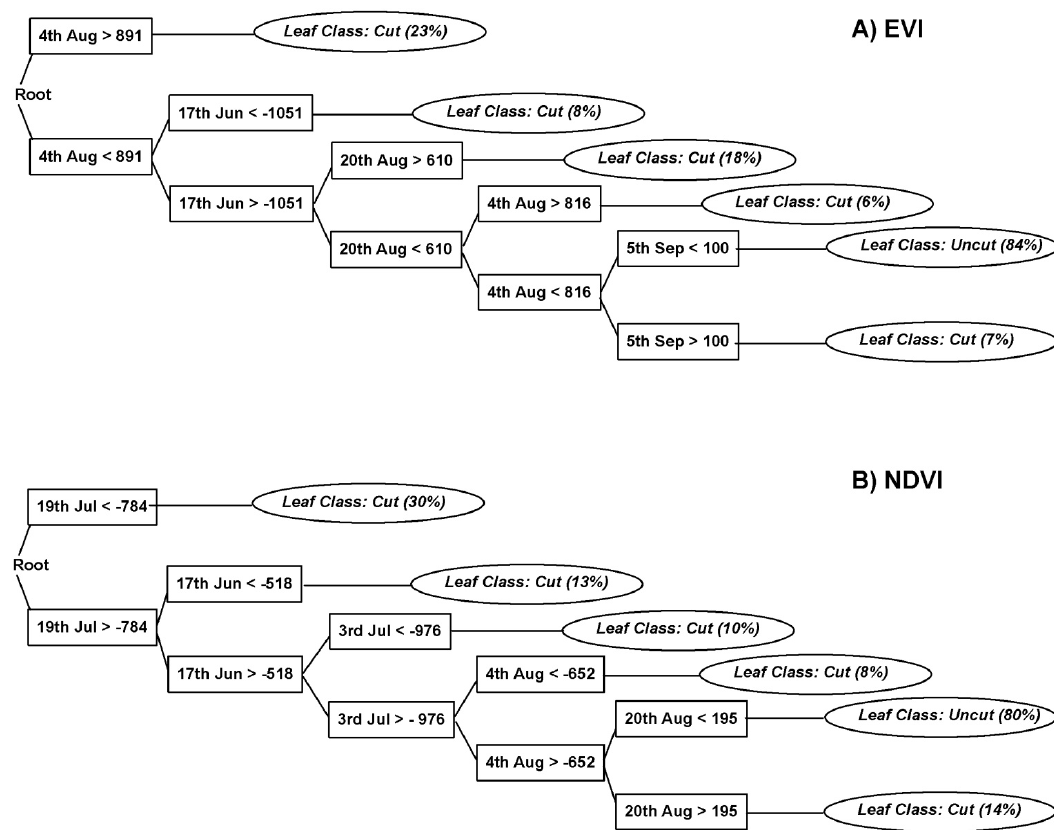
Figure 12. Classification tree and splitting rules of the best case first difference series for EVI ( a ) and NDVI ( b ). Values are in VI × 10000. Percentages in parentheses represent